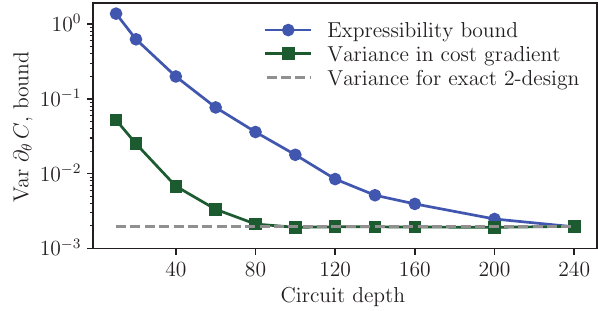
FIG. 5. Comparison of scaling of bound and gradients. The scaling of the bound on the variance in the gradient (blue), given in Eq. (16), and the variance in the partial derivative (green) as a function of the ansatz depth for n = 8 qubits. The dashed line indicates the predicted variance in the partial derivative for a per- fect 2-design from Ref. [63]. The derivative is taken with respect , the rotation angle of the first qubit in the middle layer to θ 1 D / 2 ( D / 2) and the variance is taken over an ensemble of 1000 uni- taries. We choose to show the state and Hamiltonian dependent bound here, as given in Eq. (16), because as we are looking at the , this bound is gradient with respect to θ 1 D / 2